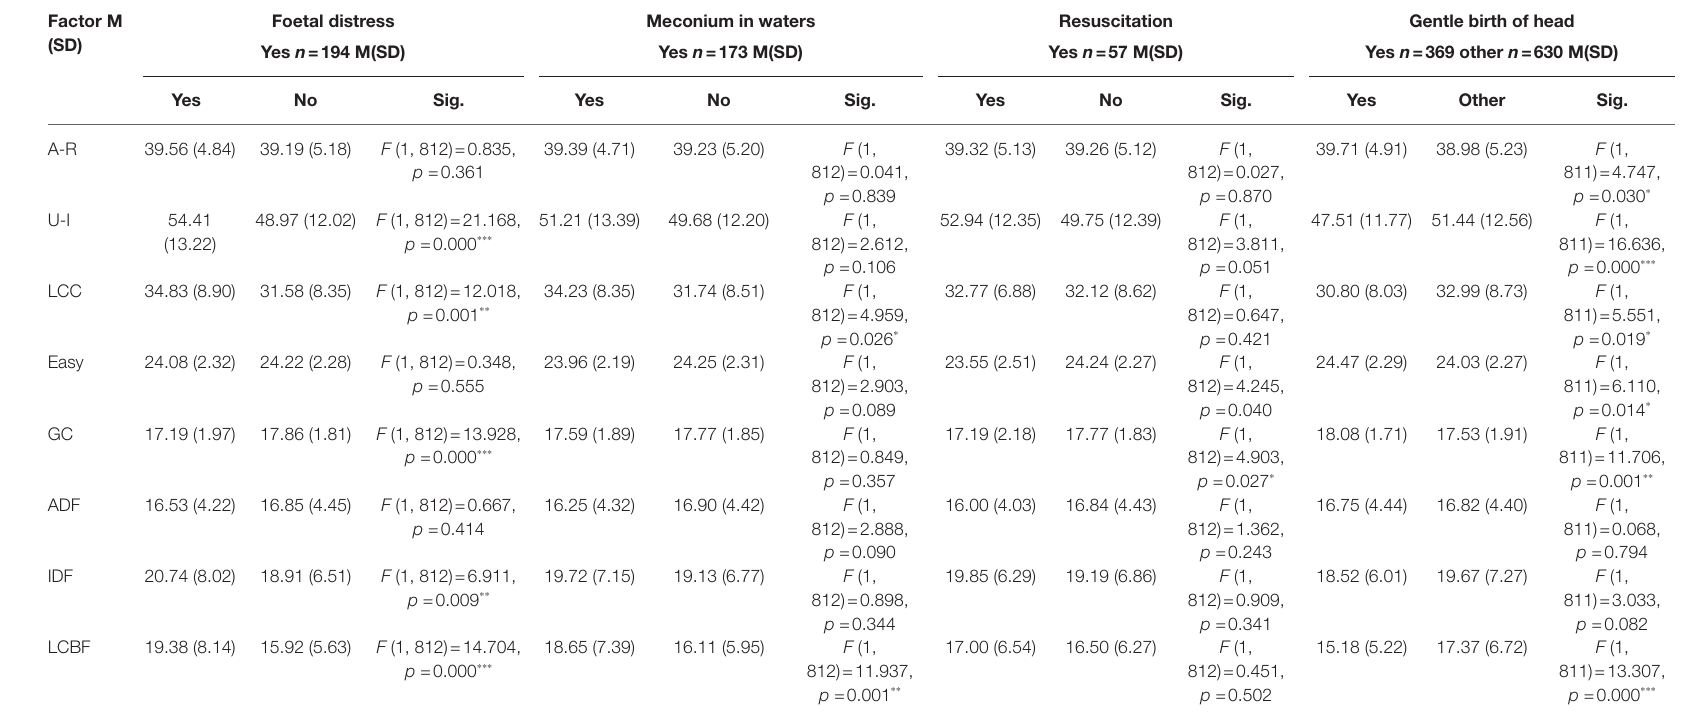
TABLE 7 | Foetal distress signals, gentle birth of head and MABS.